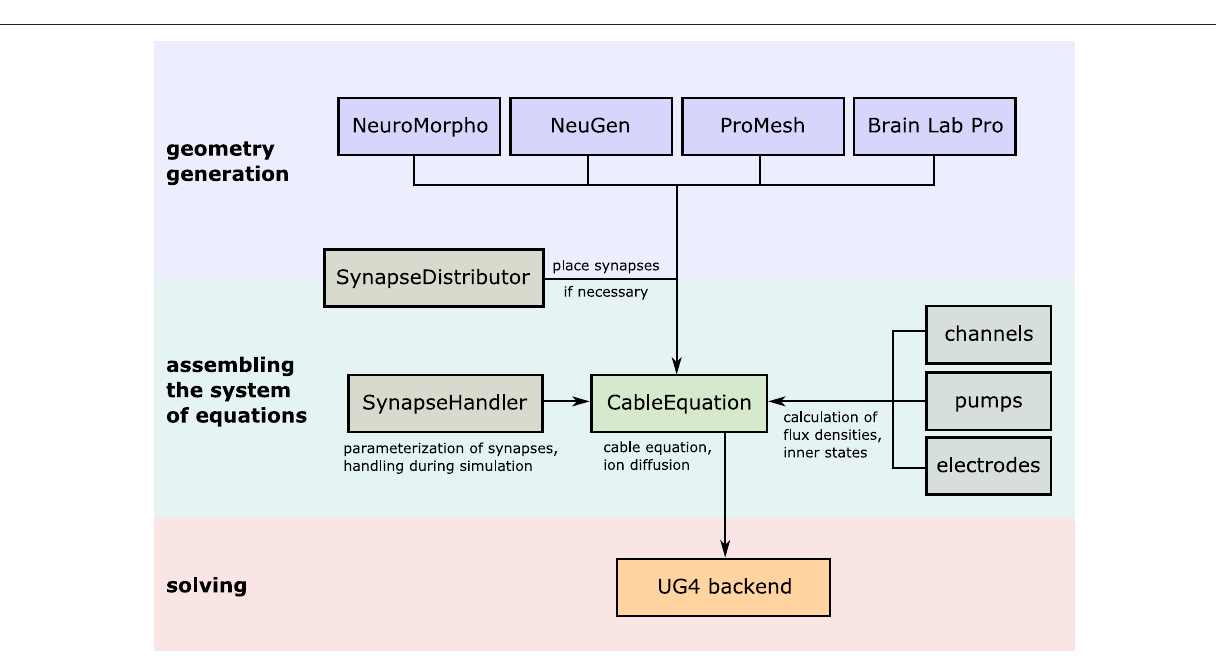
FIGURE 5 | Illustration of the simulation workflow. After creation of a neuronal (network) morphology, the system of linear equations emerging from the cable equation is assembled by the central class CableEquation ; synapse handling (i.e., activation, calculation of fluxes, parallel coordination) is taken care of by the class SynapseHandler , while all trans-membrane fluxes are handled by individual classes which all derive from a common interface known to the CableEquation class. The system is solved using UG4 solvers and parallelism.